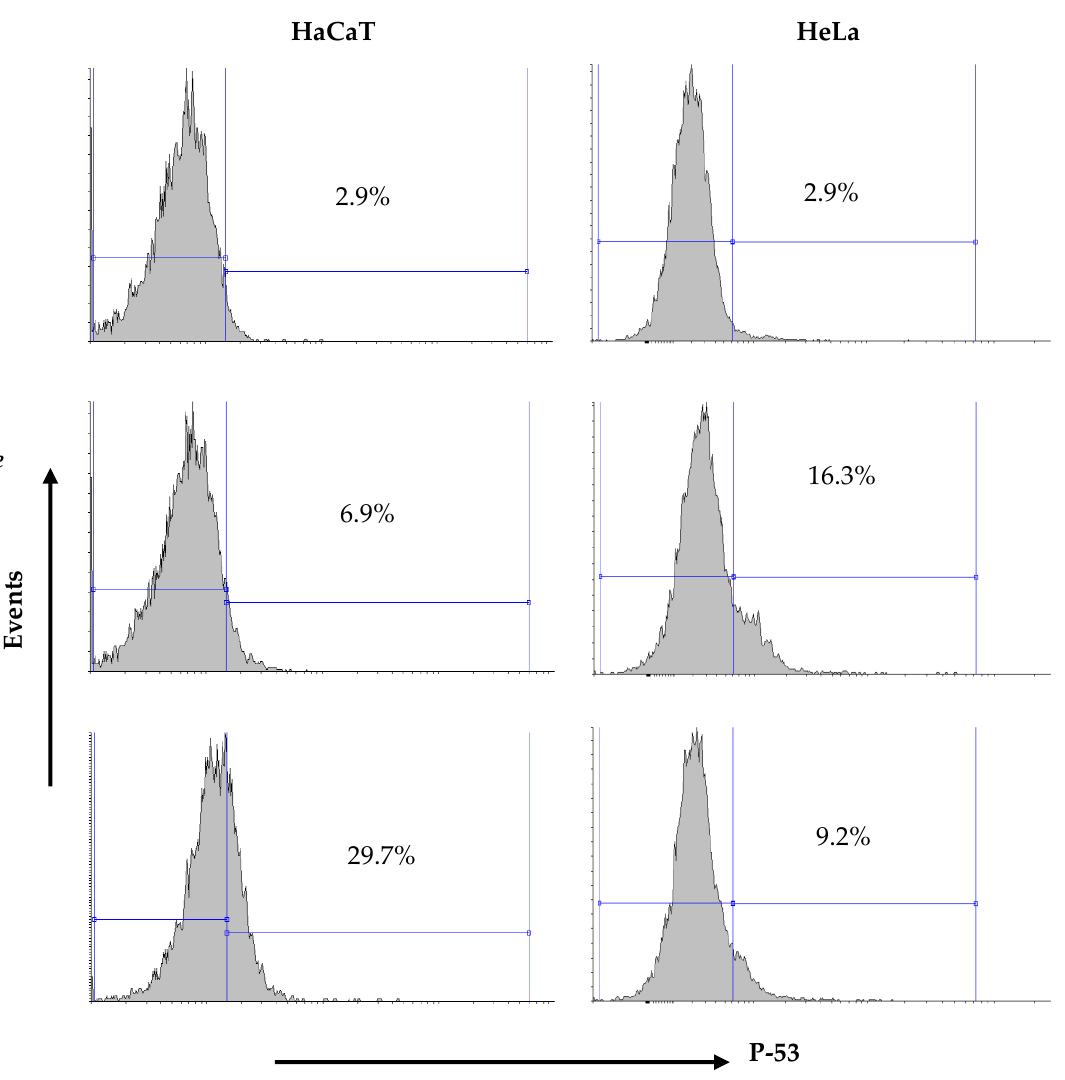
Figure 3. Effect of incubation with S. chinantlense extract or cisplatin at the IC 50 value for 48 h on the level of active p53 in HeLa and HaCaT cell lines.